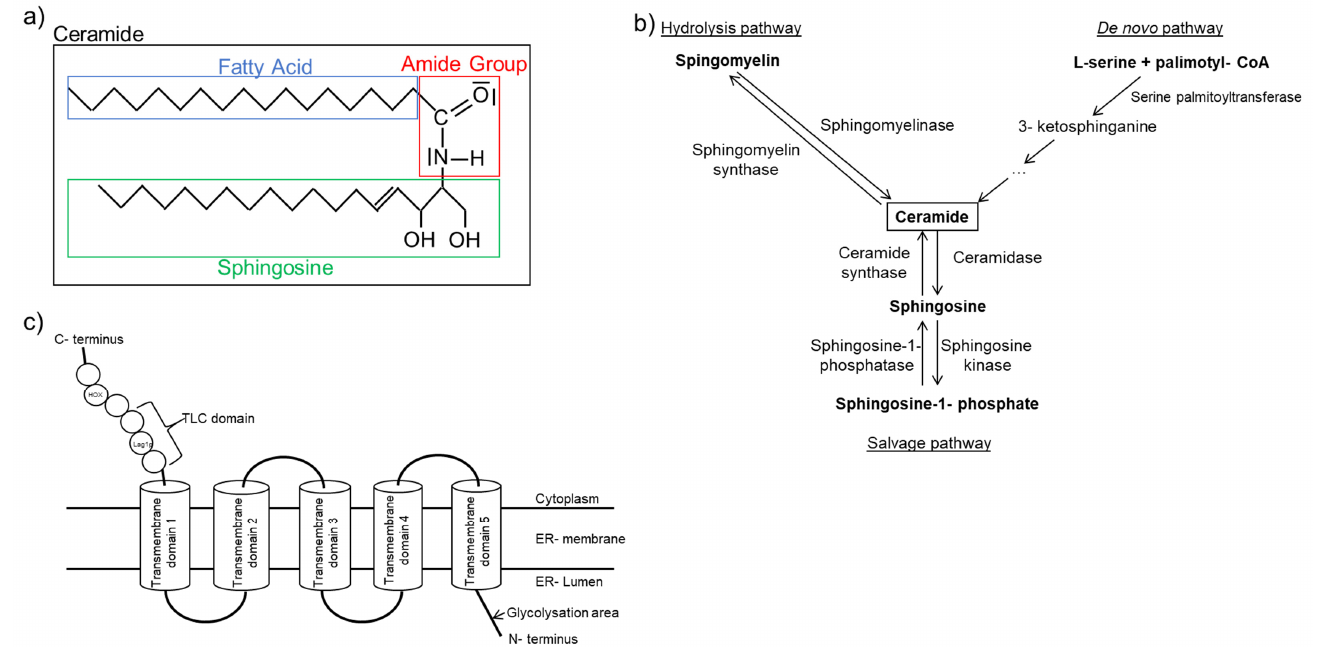
Figure 1. Ceramide structure and synthesis. ( a ) Schematic diagram illustrating ceramide structure. ( b ) Simplified ceramide synthesis pathways with essential enzymes in the respective pathway. ( c ) Schematic presentation of ceramide synthase structure based on previous findings